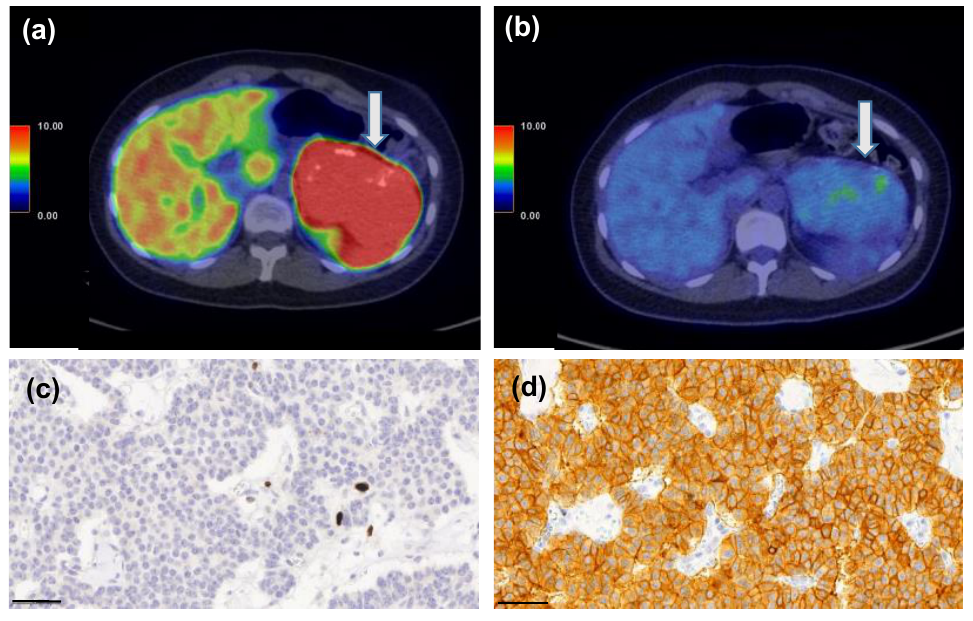
Figure 7. A 25-year-old female patient who had MEN1 syndrome had a 10-cm mass in the tail of the pancreas. [ 68 Ga]Ga-DOTANOC-PET/CT ( a ) showed intense uptake (SUVmax 93.3 g/mL) and 18 F- FDG-PET/CT ( b ) was also positive (SUVmax 4.5 g/mL vs. liver background activity SUVmax 3.6 g/mL). She underwent a distal pancreatectomy and splenectomy and histopathological analysis re- vealed a G1 T3N0 PNEN (Ki-67 PI 1%, c ). Strong expression of somatostatin receptors (SSTR) 1 ( d ), 2 ( e ), 3 ( f ), and 5 ( h ) were detected, whereas SSTR4 ( g ) showed only weak expression. Scale bar 50 µm, images captured with CaseViewer software 40 × objective.